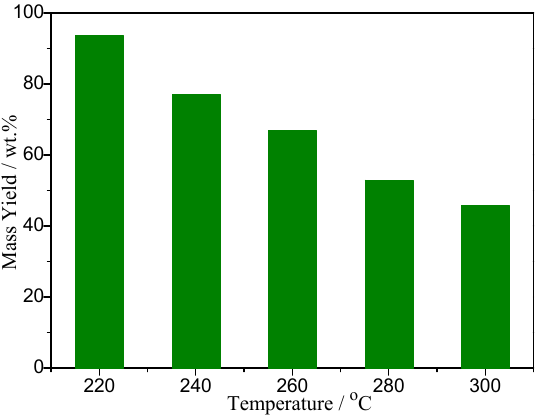
Figure 1. The effect of torrefaction temperature on the mass yield of corn cobs.